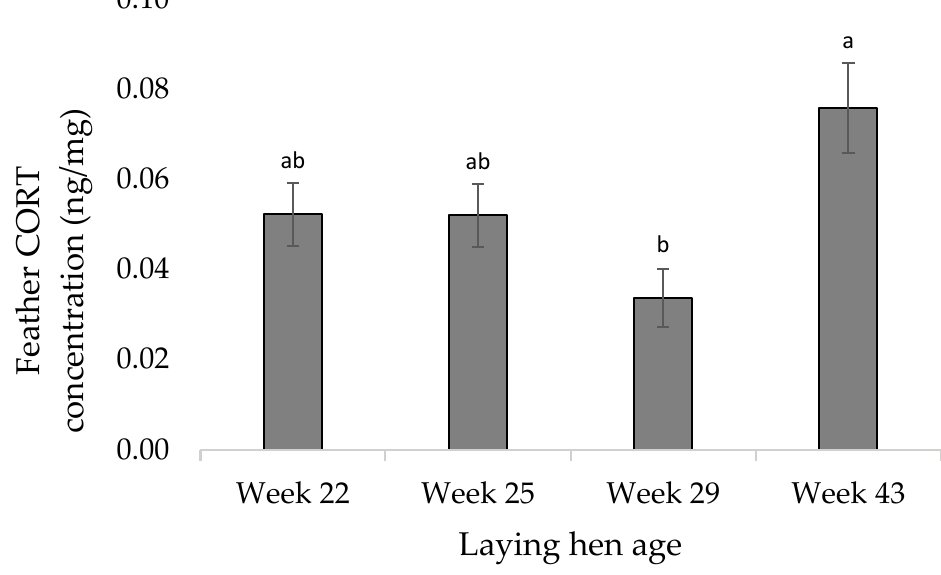
Figure 4. Least square means estimates (±SEM) of the total feather corticosterone (CORT) concen- trations by age in weeks. Bars lacking a common superscript differ at p < 0.05.